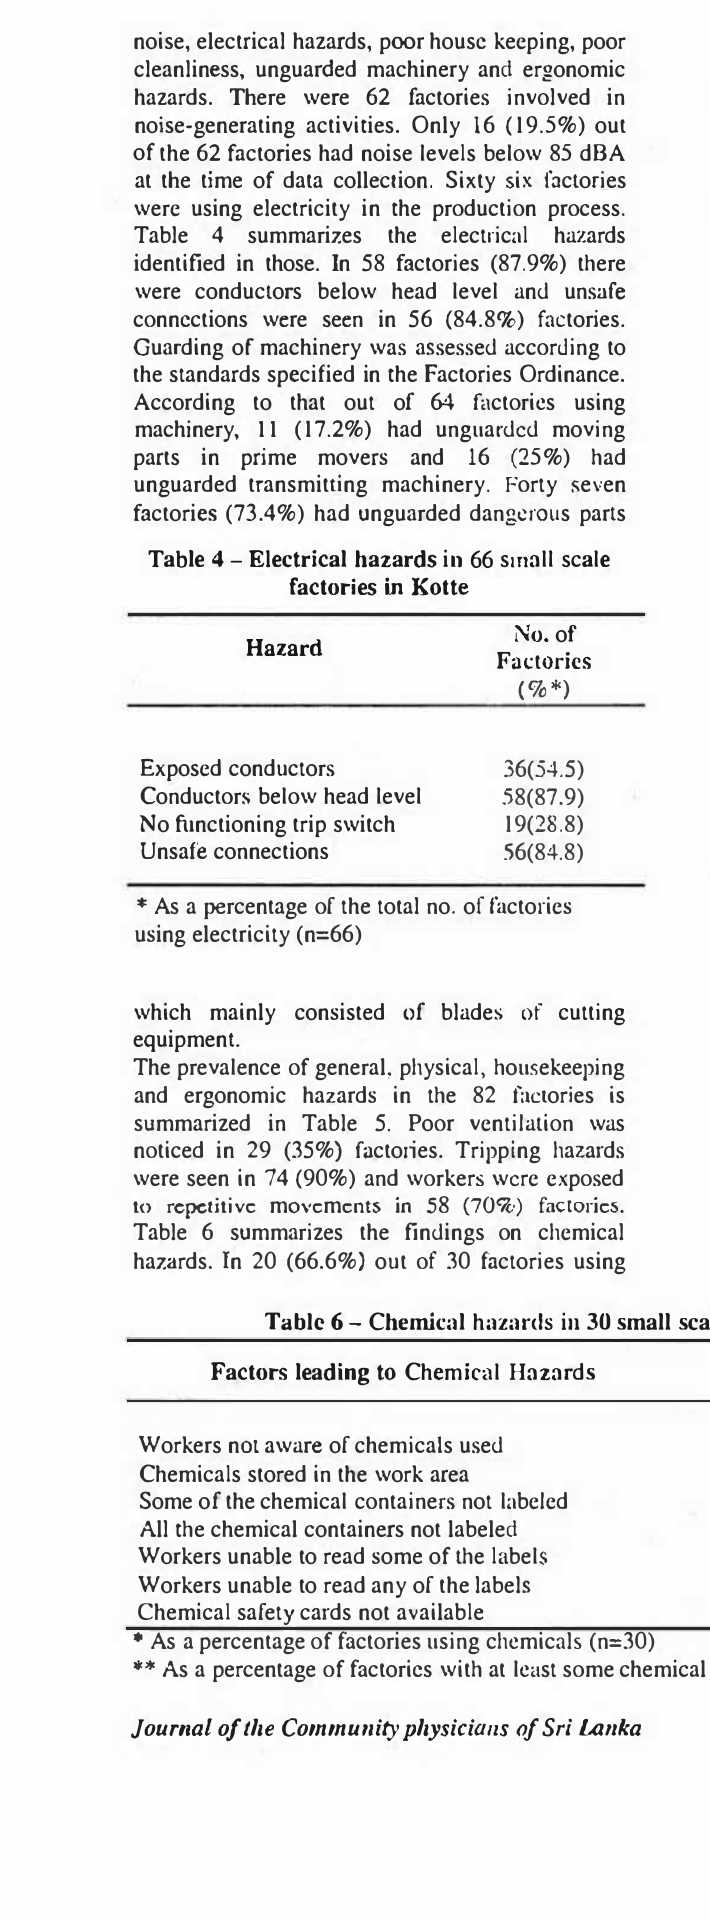
Table 5 -Hazards in the work environment